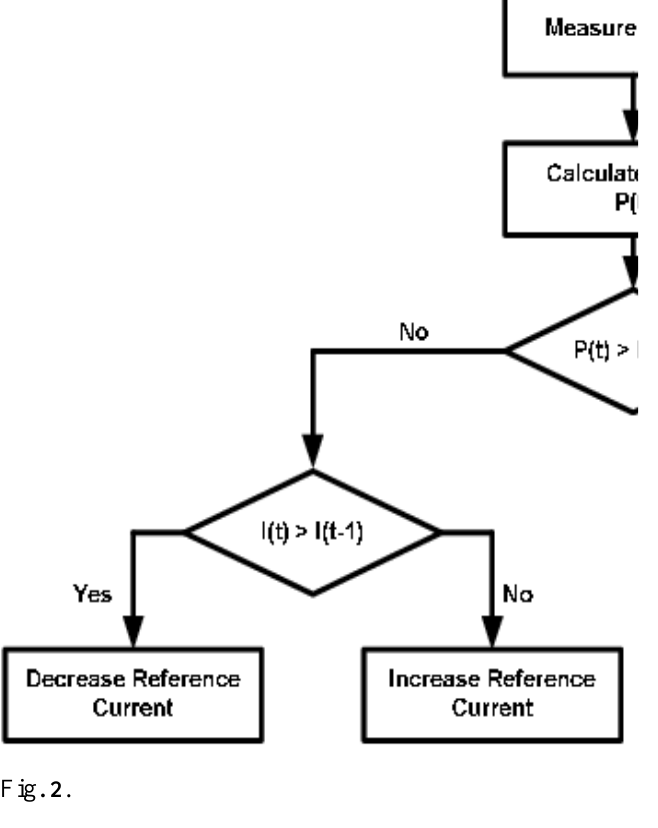
Here are the steps of the Hill Climbing algorithm: Initialize: Start with an initial solution. This could be a random solution or a solution based on some heuristics.